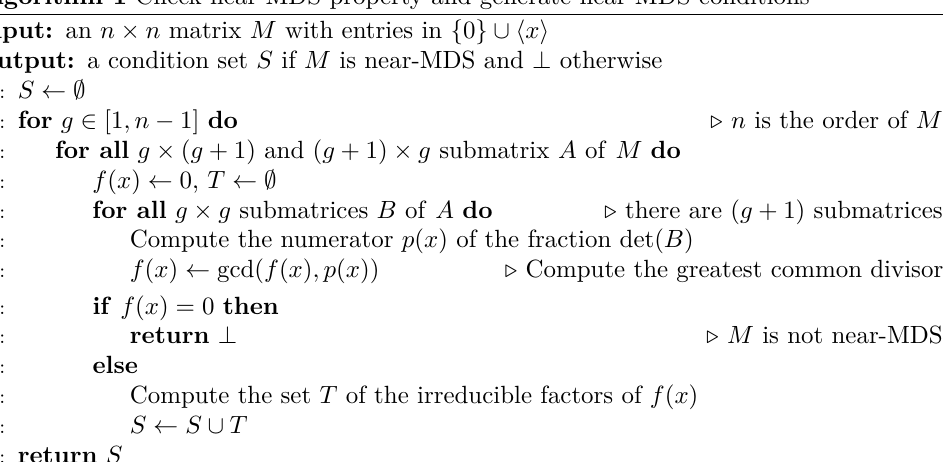
Algorithm 1 Check near-MDS property and generate near-MDS